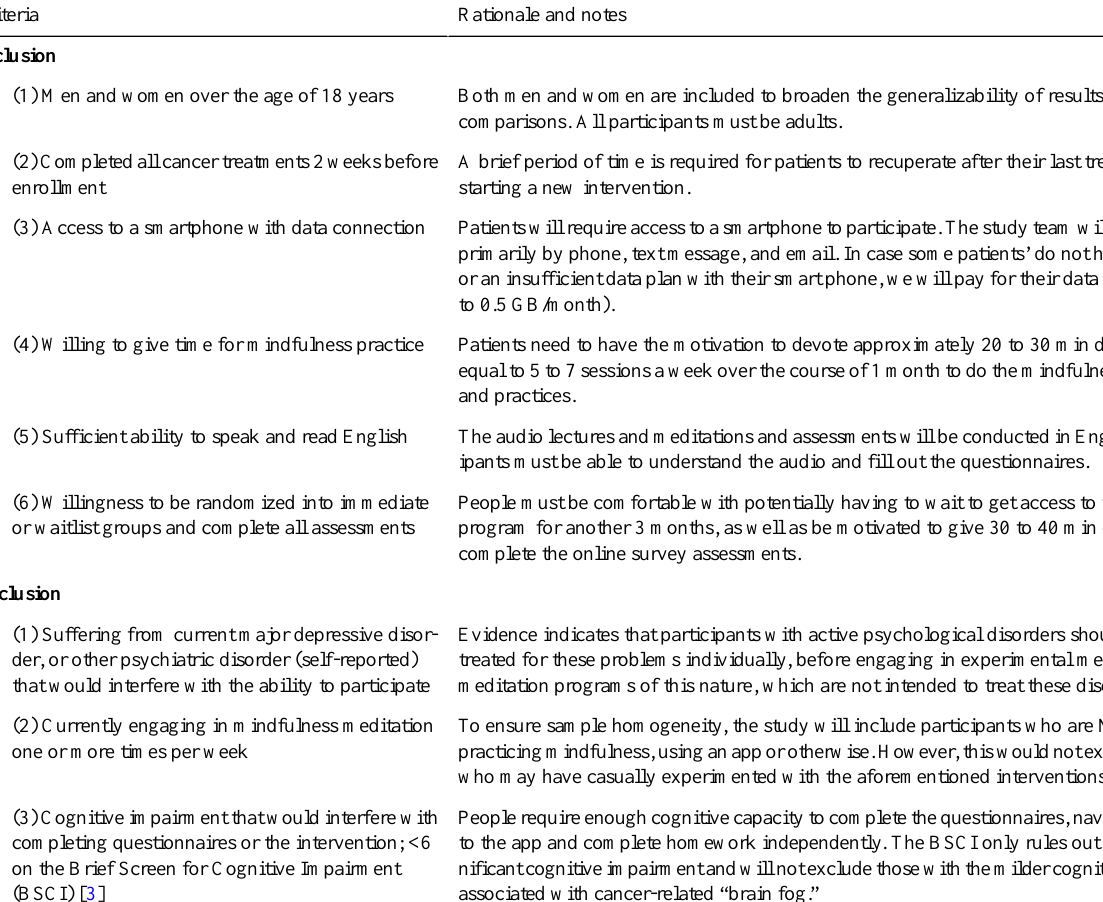
Table 1. Inclusion and exclusion criteria.